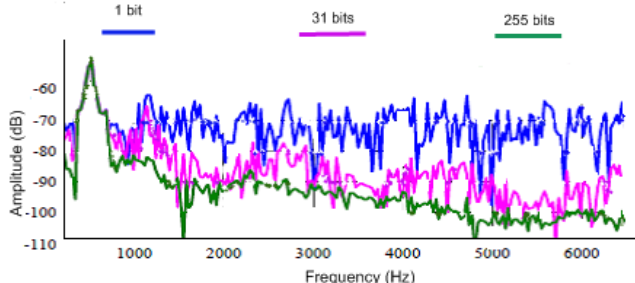
Figure 11. Vibration spectra with different length pulse-trains using cyclic Simplex coding. (Adapted from [10].)